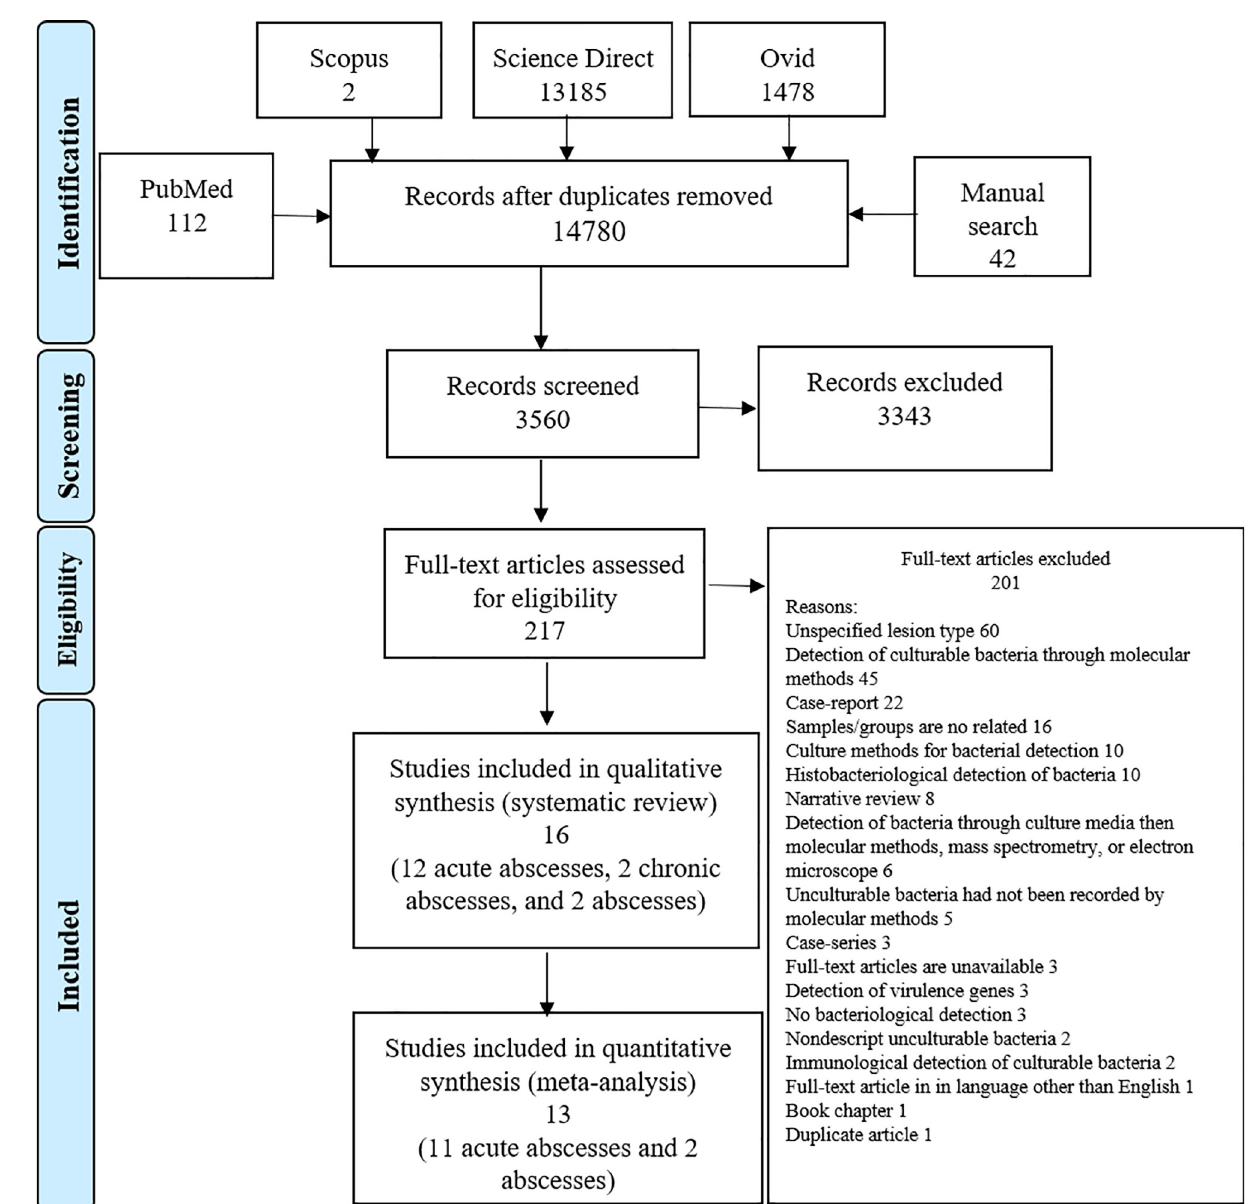
Fig 1. PRISMA flowchart of the study selection process showing inclusion and exclusion of the identified